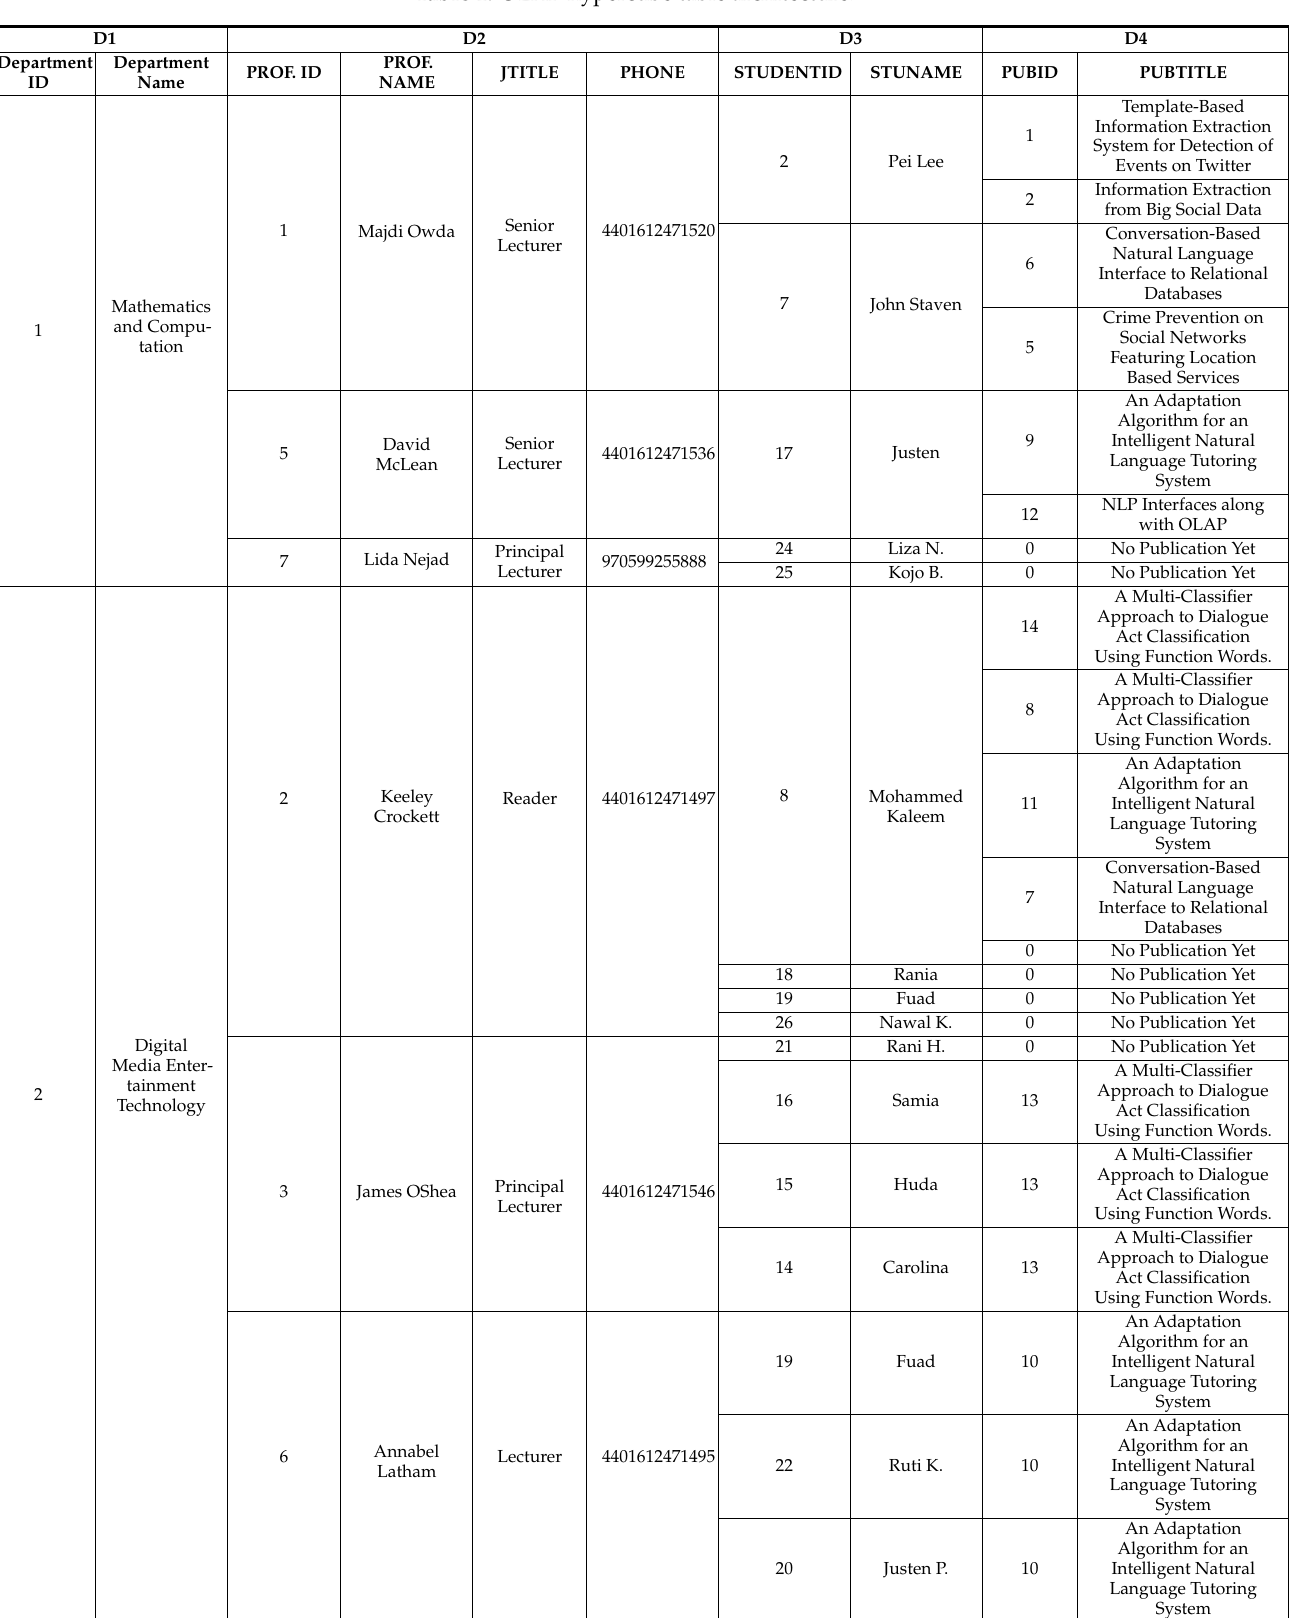
Table 1. OLAP hypercube table